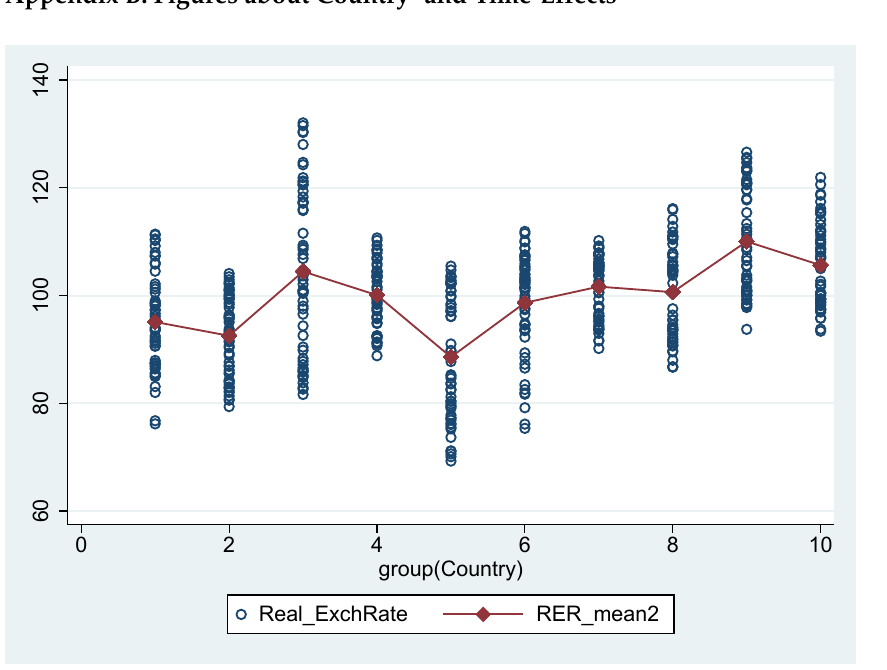
Figure A1. Scatter Plot for Country